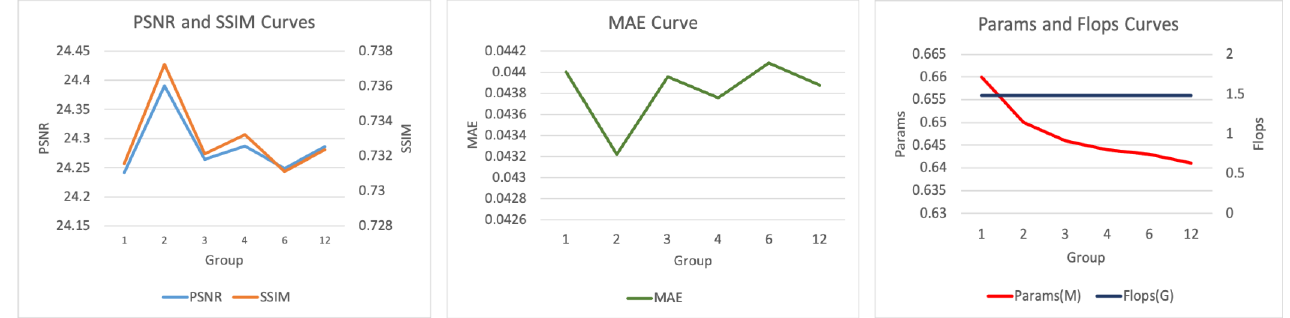
Figure 12. Performance curves of different group numbers on the AID dataset. Higher PSNR and SSIM values denote a better performance. Lower MAE values denote a better performance.